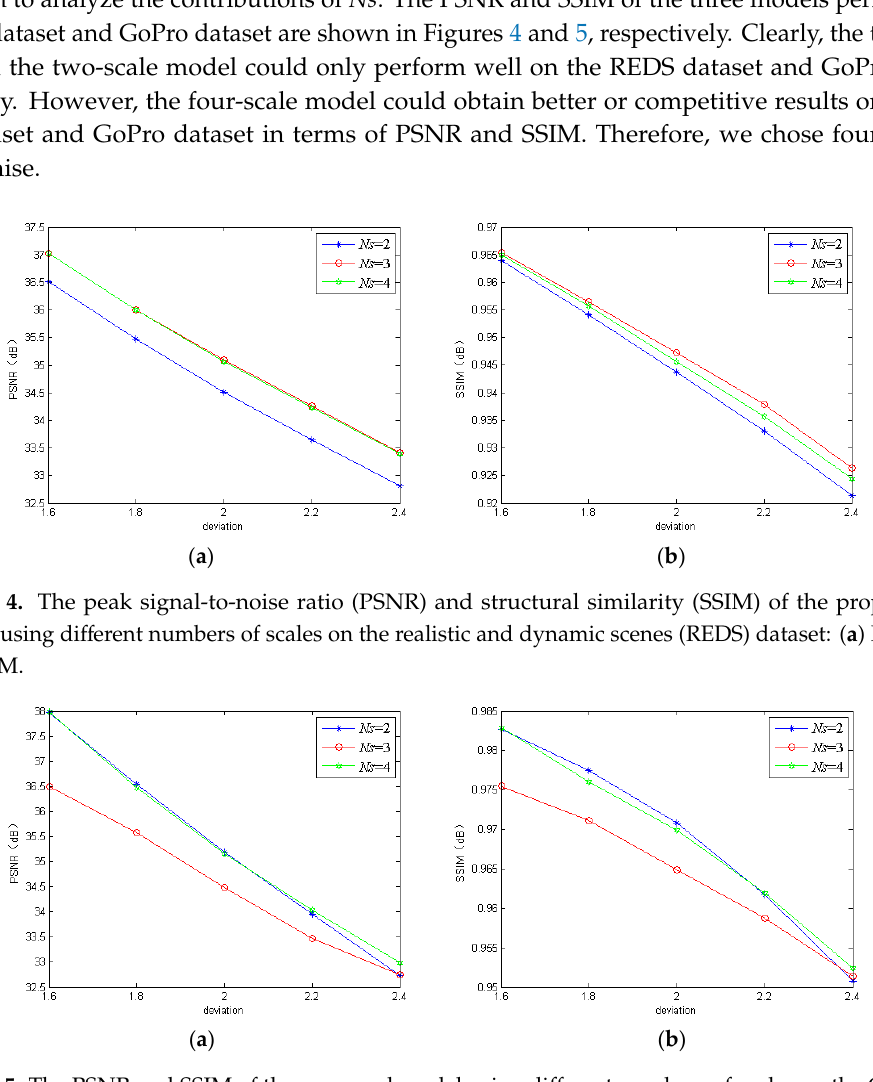
Figure 5. The PSNR and SSIM of the proposed model using different numbers of scales on the GoPro dataset: ( a ) PSNR; ( b ) SSIM.